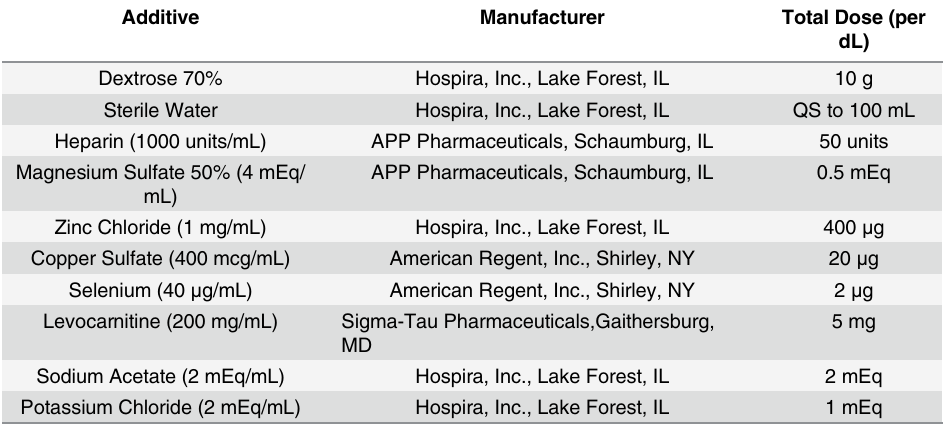
Table 1. Standard Parenteral Nutrition Additives for All Solutions Compounded in the Precipitation Studies. Additive Manufacturer Dextrose